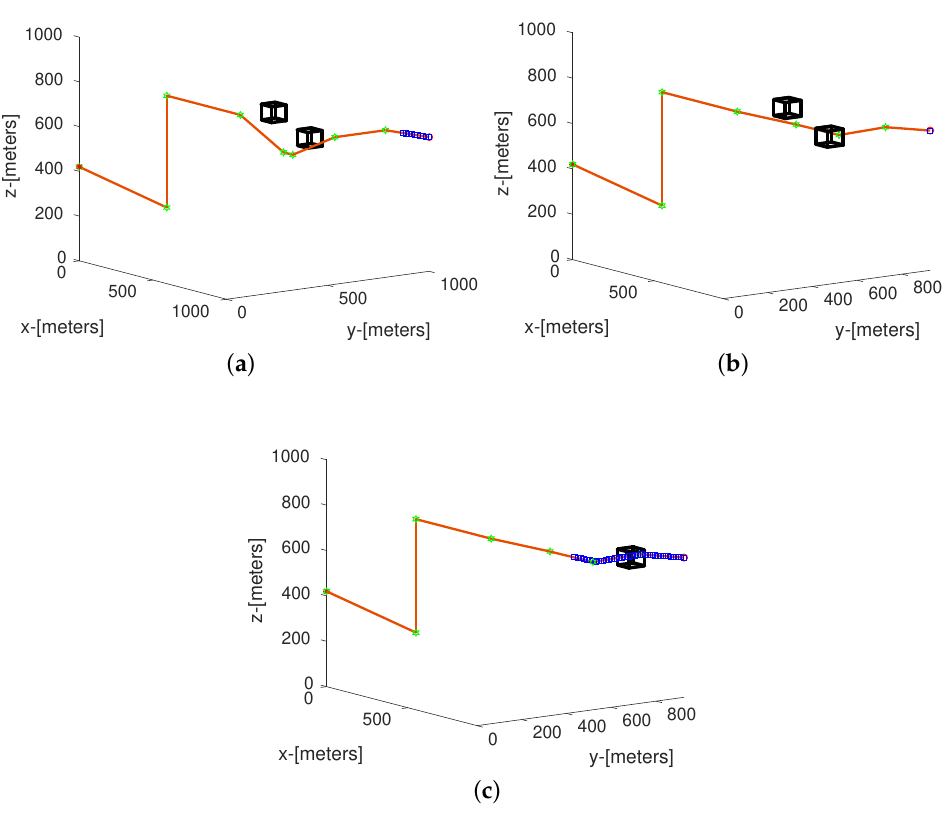
Figure 11. Network structure and state transition. ( a ) Collision in time of flight t = 11. ( b ) New ρ x ( F ) after first collision. ( c ) New ρ x ( F ) after first